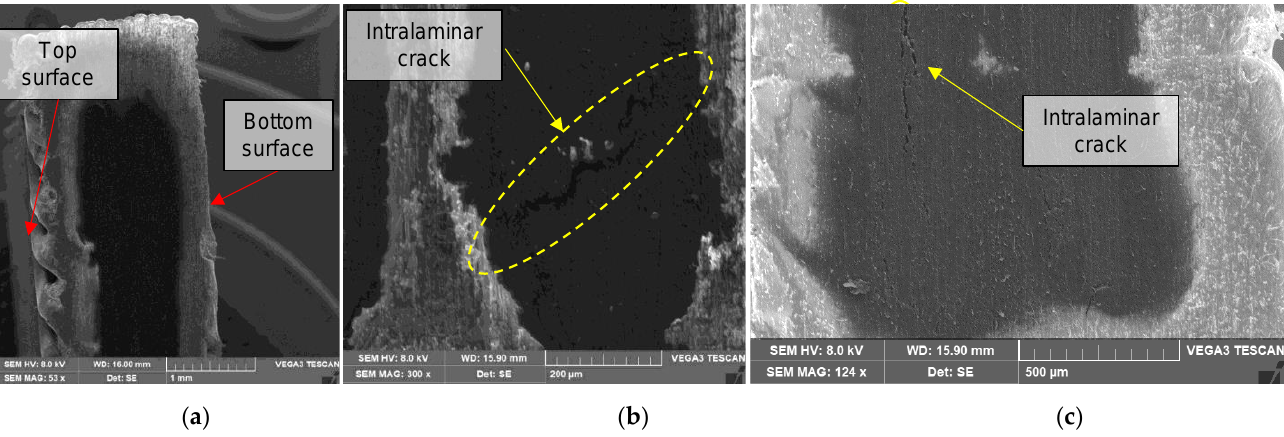
Figure 13. SEM transversal cut of a 4/16 carbon layers 45° flat printed sample: ( a ) 53×, ( b ) 300×, ( c ) 124×.